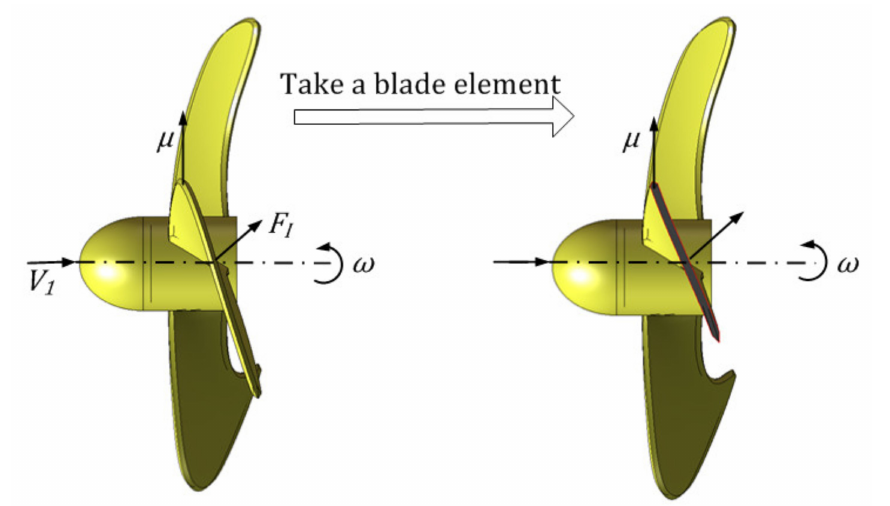
Figure 3. Schematic diagram of driving force of the drag-type